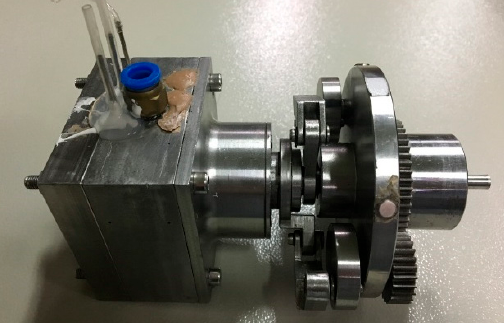
Figure 25. Prototype of the MSRE with high coaxiality. Energies 2018 , 11 , x FOR PEER REVIEW